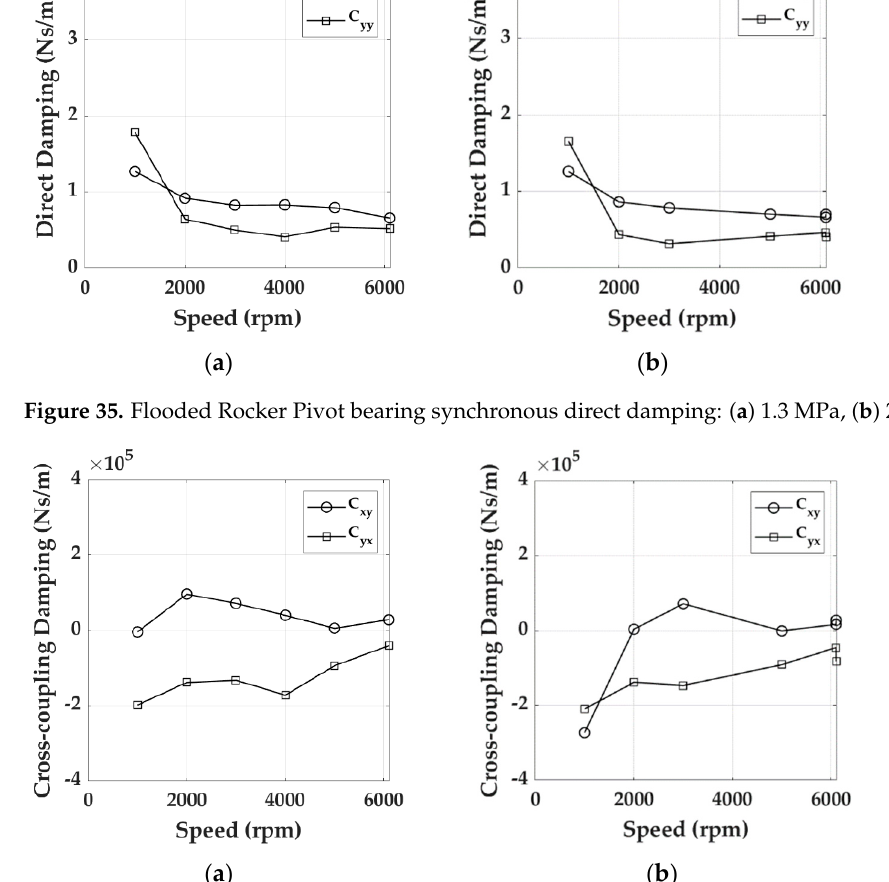
Figure 36. Flooded Rocker Pivot bearing synchronous cross-coupling damping: ( a ) 1.3 MPa, ( b ) 2.1 MPa.